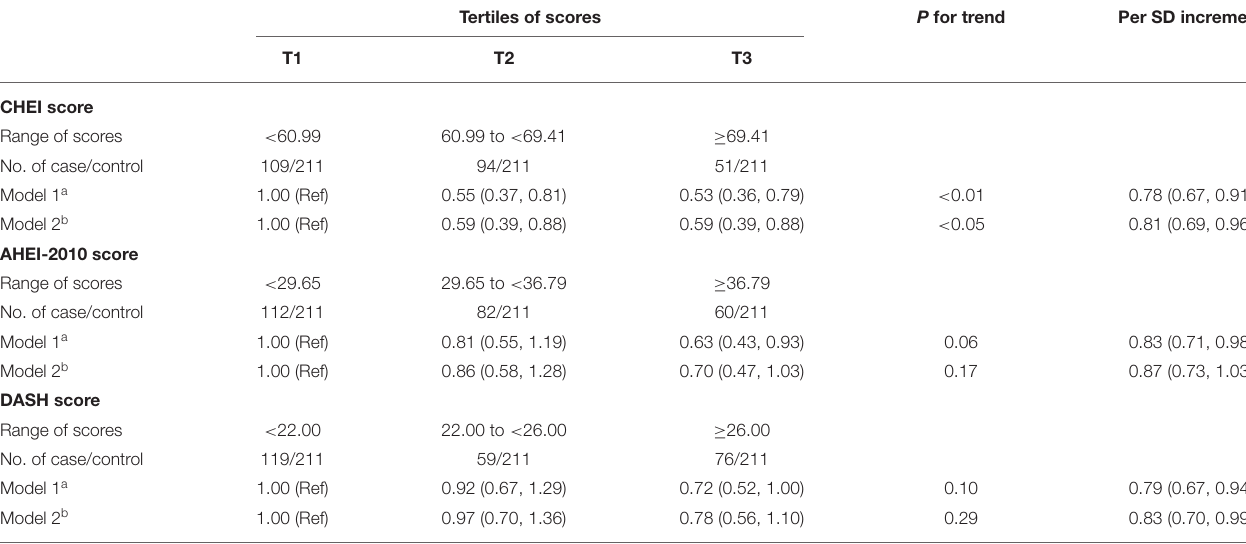
TABLE 2 | Adjusted OR and 95 % CIs for asthenoteratozoospermia risk according to tertile of dietary quality scores. Tertiles of